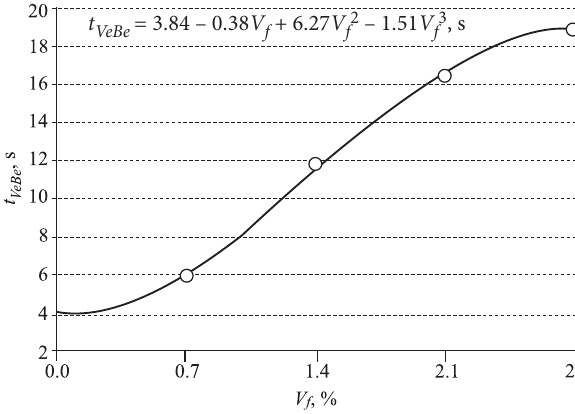
t VeBe = 3.84 – 0.38 V f + 6.27 V f 2 – 1.51 V f 3 ,